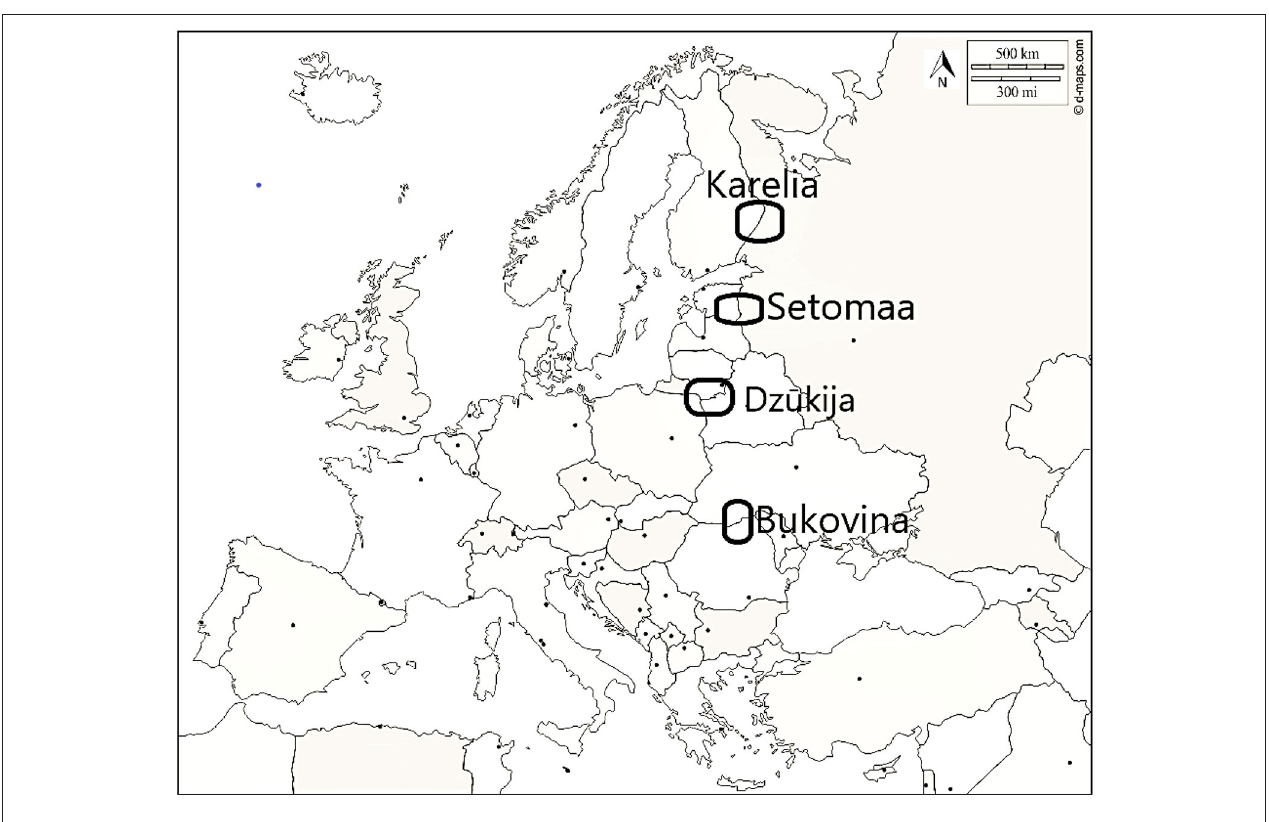
FIGURE 1 | Research sites.